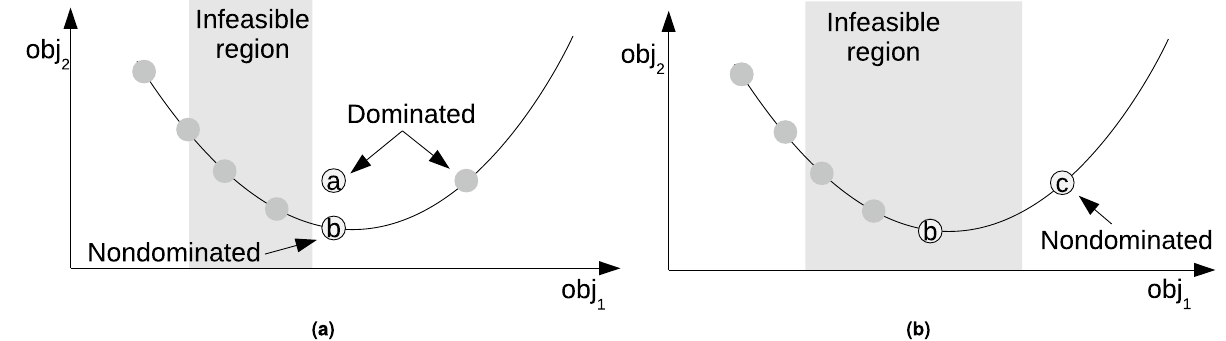
Figure 5. Pareto front for a single segment where the dots on the curve represent the evenly distributed speed profiles stored in the database. ( a ) Infeasible region covers the middle part of the Pareto front. ( b ) Infeasible region extends beyond the last nondominated solution (solution b ) on the Pareto